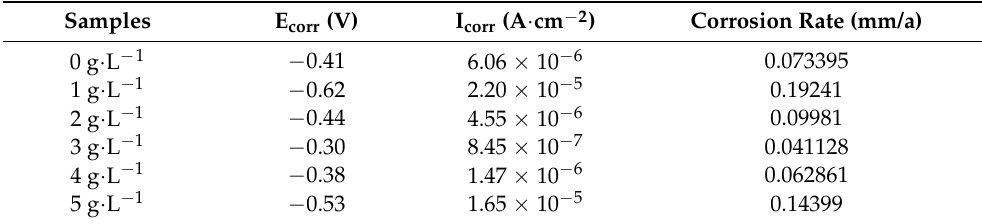
Table 5. Corrosion electrochemistry parameters of coatings with different particle concentrations prepared on 45 steel substrates through scanning